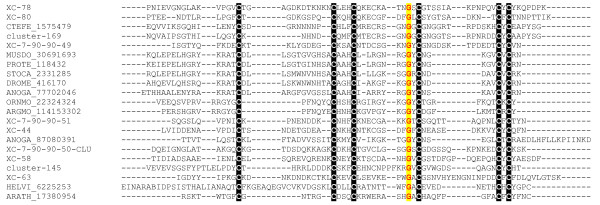
Alignment of selected Xenopsylla cheopis peptides of the FS family with defensin peptides. The conserved cysteine framework C...C-X-X-X-C...G-X-C ...C-X-C is indicated. Sequences from the present work start with XC or cluster; other sequences are from GenBank and consist of 5 letters and their gi¦ accession number. The five letters represent the genus name (first 3 letters) followed by 2 letters from the species name; Accordingly, CTEFE: Ctenocephalides felix, MUSDO: Musca domestica, PROTE: Protophormia terraenovae, STOCA: Stomoxys calcitrans, DROME: Drosophila melanogaster, ANOGA: Anopheles gambiae, ORNMO:Ornithodorus moubata, ARGMO: Argas monolakensis, HELVI:Heliothis virescens, ARATH: Arabidopsis thaliana. The aminoterminal part of the peptides is not shown.